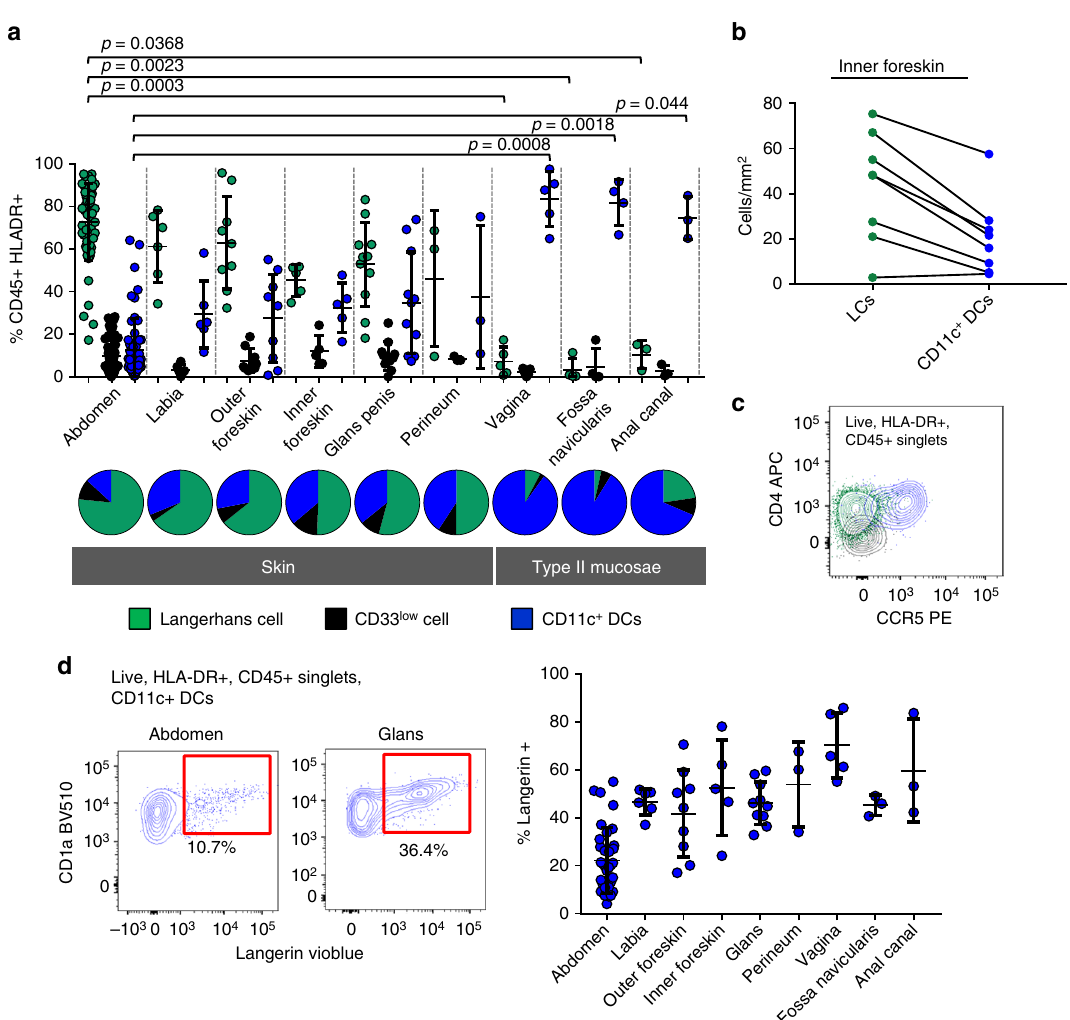
Fig. 5 Phenotypic analysis of epidermal mononuclear phagocytes in anogenital tissues. a Mononuclear phagocytes were liberated from anogenital epidermis and using Type IV collagenase and the relative proportion of each subset within the CD45 + HLA-DR + gate was determined and is shown as a mean ± the standard deviation with each dot representing an individual donor. Statistics for subsets in each tissue were generated using the Kruskal – Wallis test (Abdominal skin = 75, Labia = 6, Outer Foreskin = 9, Inner Foreskin = 5, Glans Penis = 11, Perineum = 3, Vagina = 5, Fossa Navicularis = 4, Anal Canal = 3). A pie chart summarising the average proportions of each epidermal subset in each anogenital tissue is shown underneath. b Using fl uorescent microscopy we outlined the epidermis of inner foreskin (using pan-keratin stain as a reference) and calculated the density of CD11c + DCs and LCs within this compartment ( n = 7). c Representative fl ow cytometry data using inner foreskin showing that CCR5 is expressed more highly by epidermal CD11c + DC than LCs or epidermal CD33 low cells. Representative of n = 5 donors. d The percentage of epidermal CD11c + DCs that express langerin in abdominal and anogenital tissues is shown. Left: Representative data from abdomen and glans penis. Right: data for each tissue is shown as a mean ± the standard deviation with each dot representing an individual donor. Donor numbers for each tissue are as described in part A, except for vaginal tissue and